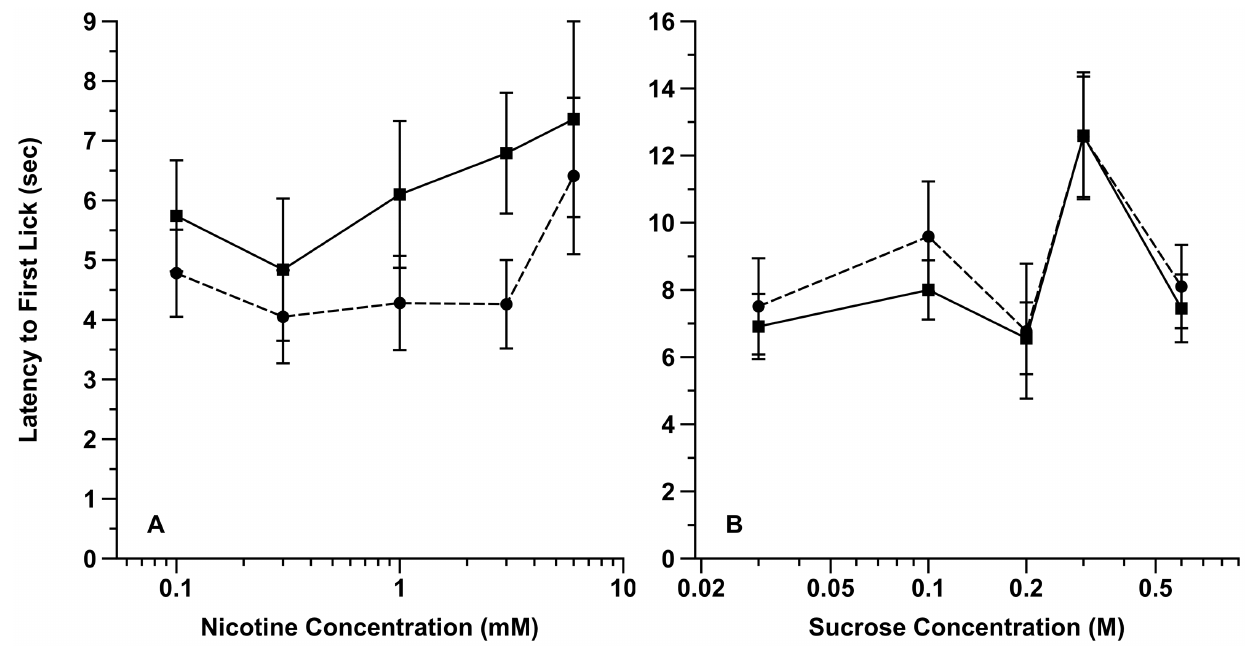
Figure 3. Latency to first lick response for a concentration range of nicotine (A) and sucrose (B) solutions by prenatal alcohol- and control-exposed rats. Compared to control, prenatal alcohol animals responded faster to nicotine (A), but not sucrose (B). The data is expressed as the average latency ( 6 se). Note: the scale on the x-axis of A and B differ. Solid circles=alcohol exposed; Solid squares=control exposed.